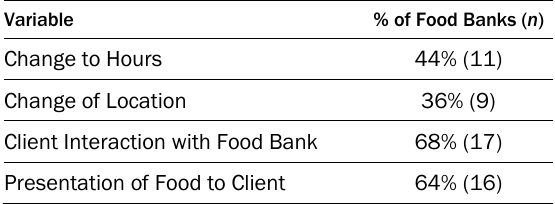
Table 3. Proportion of Seattle Food Banks ( N =25) that Had Any Website Communication on Themes Related to Food Availability, Accessibility,